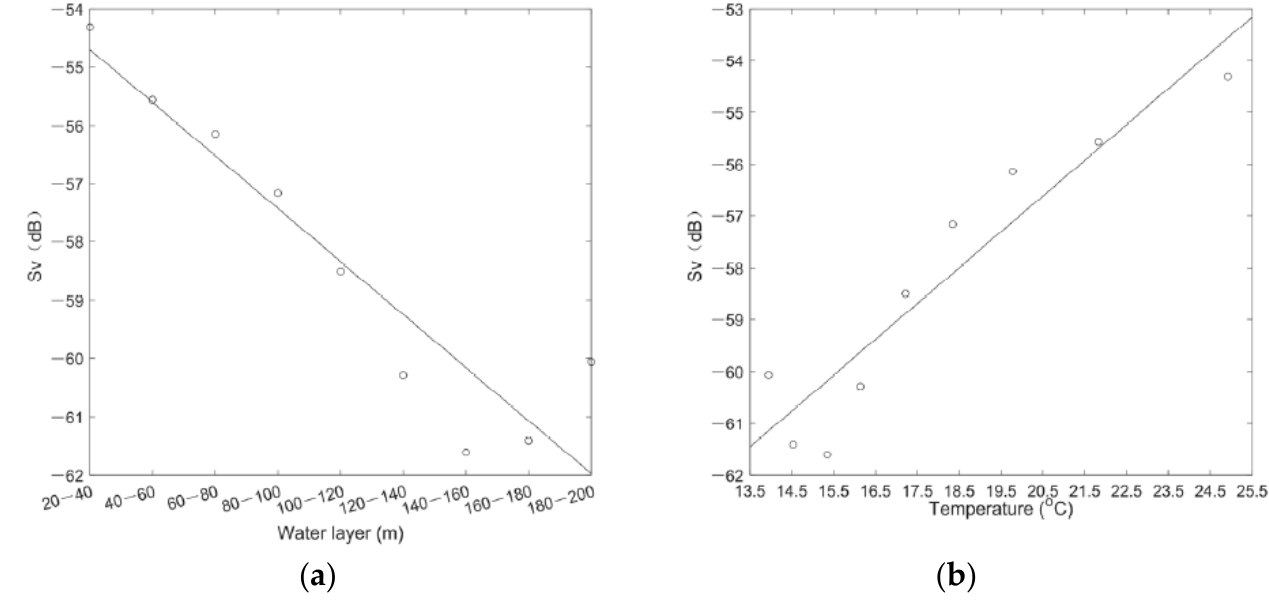
Figure 7. The Pearson correlation and linear regression analysis on the vertical level indicate the scattering strength (without Stations 24, 30, and 31): ( a ) negatively correlated with depth (R = − 0.933, p = 0.0002, p < 0.01); ( b ) positively correlated with water temperature (R = 0.939, p = 0.0002, p < 0.01).